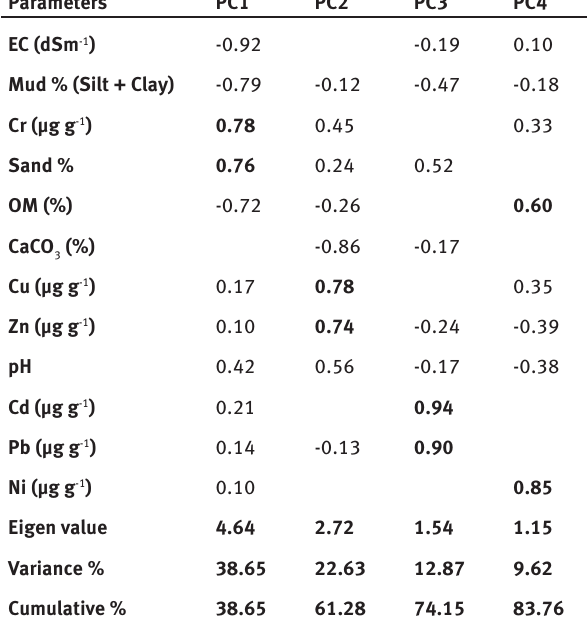
Table 9: Principal component analysis (PCA) with varimax for various sediment